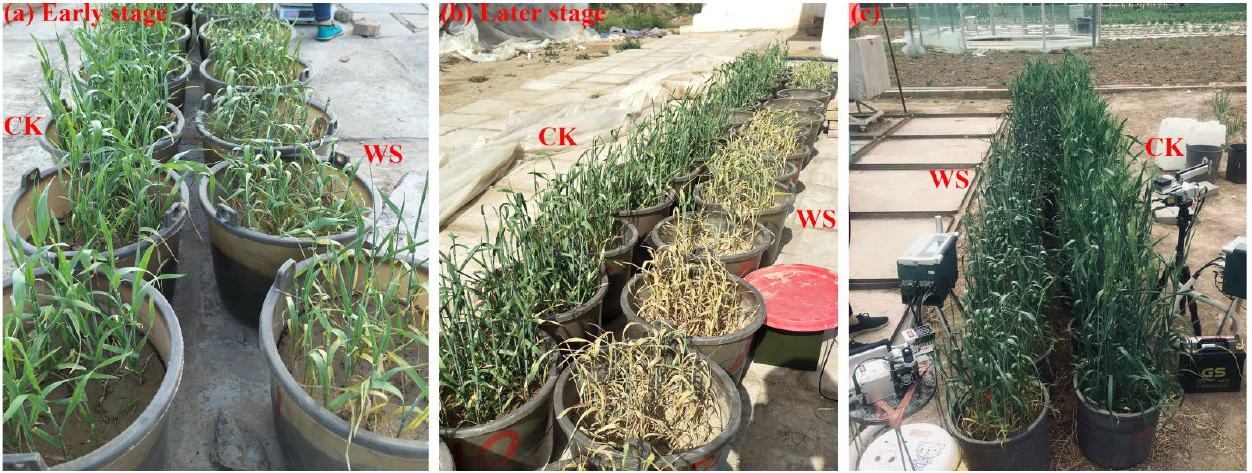
Figure 2. Experimental treatments ( a , b ) and measurement of photosynthetic parameters ( c ). CK refers to the control group. WS refers to the continuous drought group.